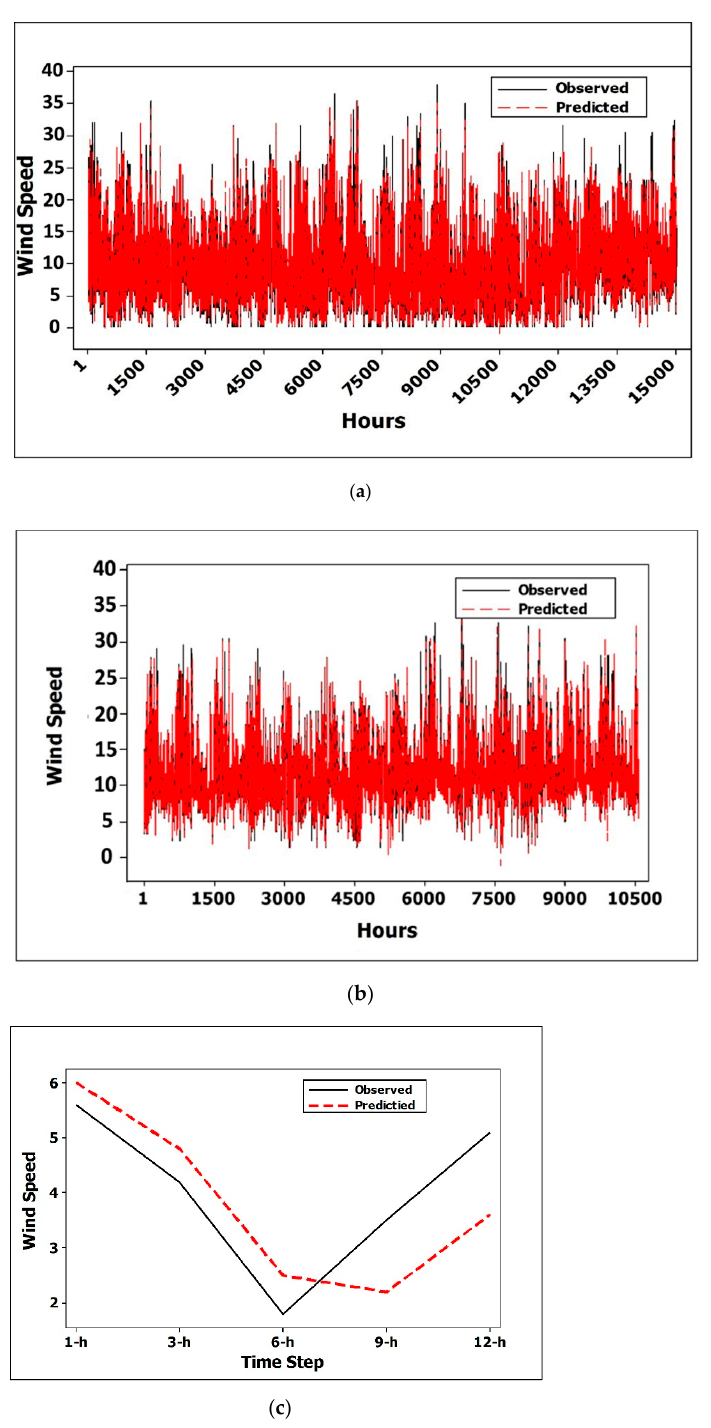
Figure 7. Wind speed (km/h) forecasting analysis of RST-LSTM (81-25-1) during the ( a ) training, ( b ) testing, and ( c ) predicting periods. The most accurate IT2F-LSTM model is demonstrated with 81-15-1 network structure and Relative Error of 0.074 and 0.088 during training and testing periods, respectively (Figure 8).